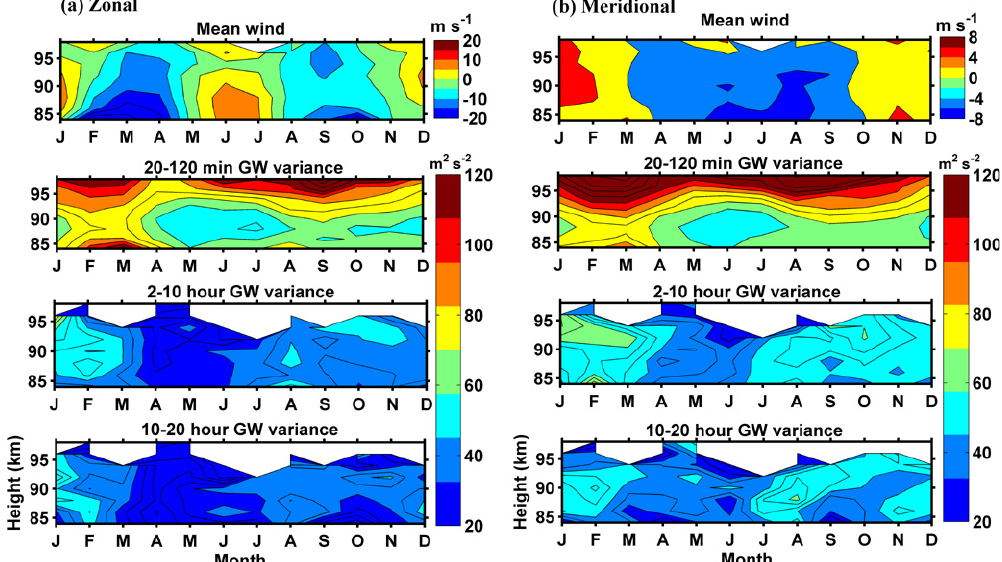
Fig. 1. A six-year (2004–2006 and 2008–2010) composite of monthly- averaged mean winds (top panel), GW variance in the 20–120min band (second panel), in the 2–10h band (third panel), and in the 10–20h band (fourth panel) for (a) zonal and (b) meridional components,